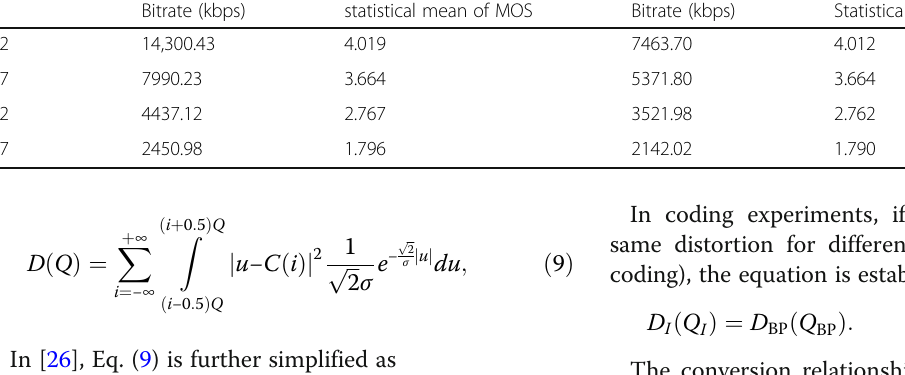
Table 10 Rate-MOS performance of two schemes QP